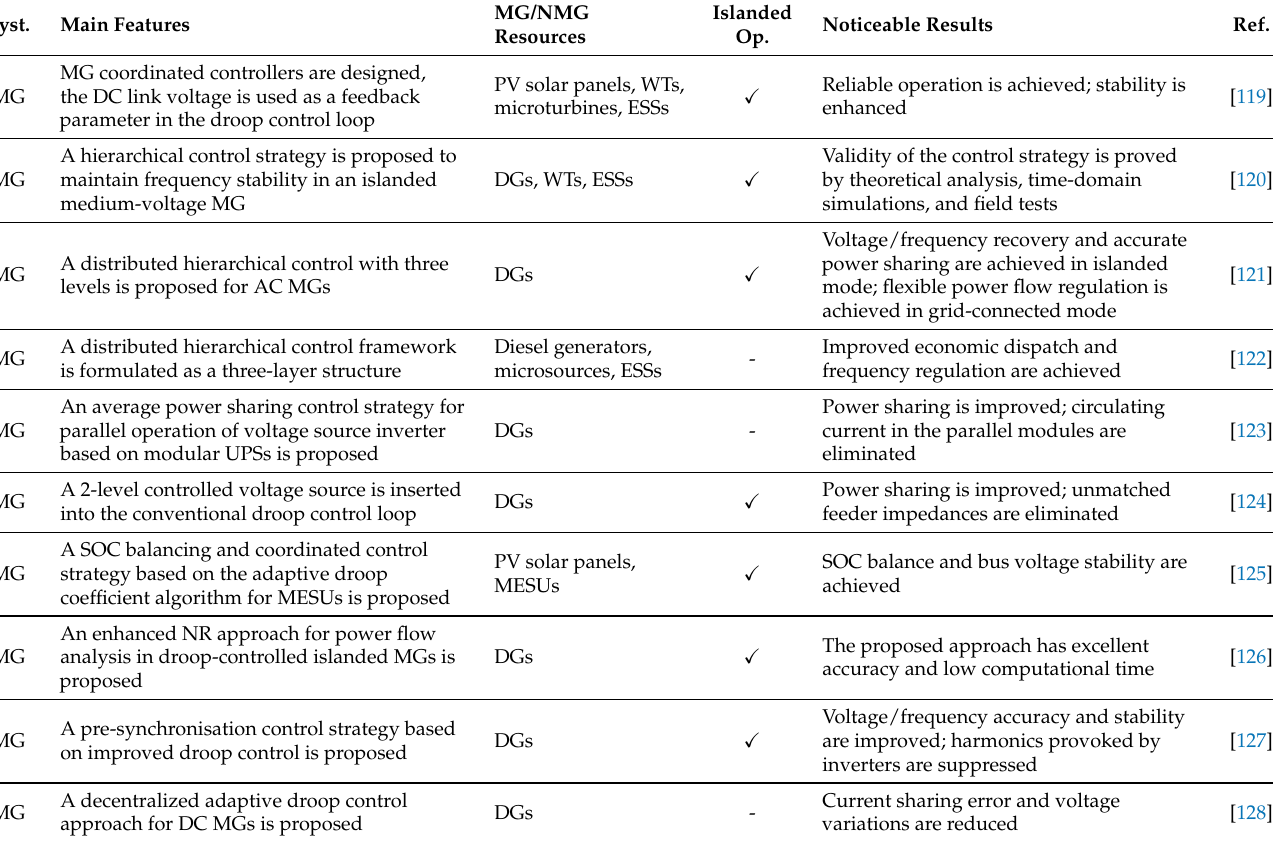
Table 9. A focus on papers dealing with droop control for MG/NMG management. DC stands for di- rect current. DG stands for distributed generator. ESS stands for energy storage system. MESU stands for multiple energy storage unit. MG stands for microgrid. NMG stands for networked microgrid. NR stands for Newton–Raphson. SOC stands for state-of-charge. UPS stands for uninterruptible power system. WT stands for wind